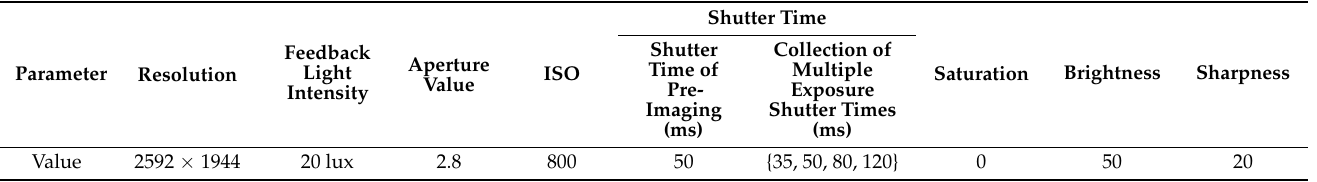
Table 1. Consistency parameter configuration.